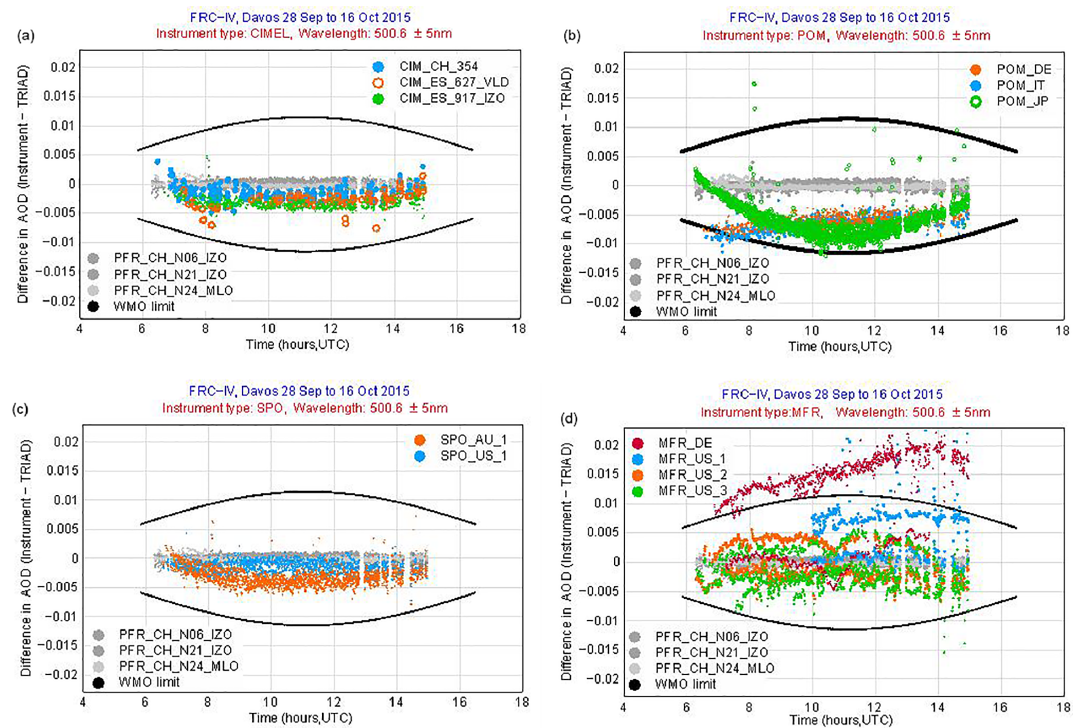
Figure 2. Comparison of the triad (gray points) with the Cimel instruments ( a , 500 ± 5nm), POM instruments ( b , 500 ± 5nm), SPO in- struments ( c , 500 ± 5nm) and with the MFR instruments ( d , 862 ± 5nm). Different colors represent different instruments for all the five comparison days, and gray lines represent the WMO AOD